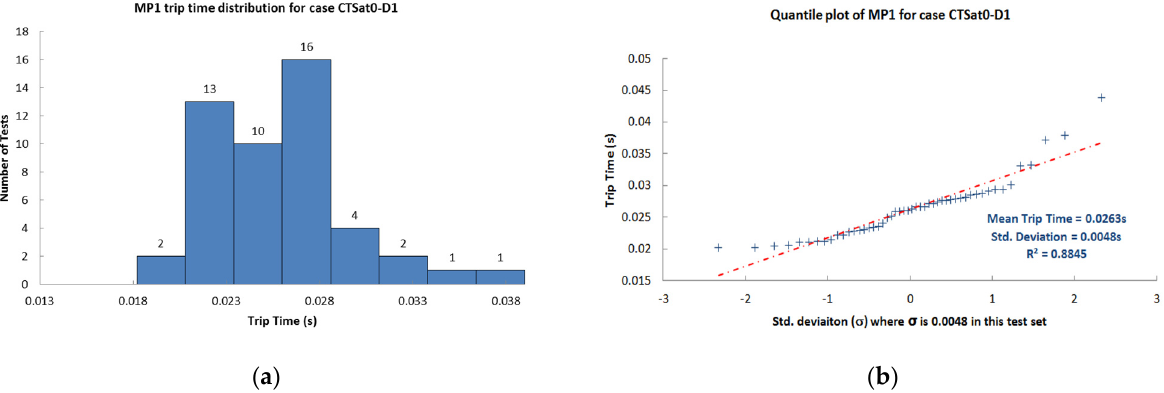
Figure 24. MP1 trip time distributions and quantile plot for case CTSat0-D1 (ideal CT, no faulty device, 3Ph-G fault at 50% of the feeder).